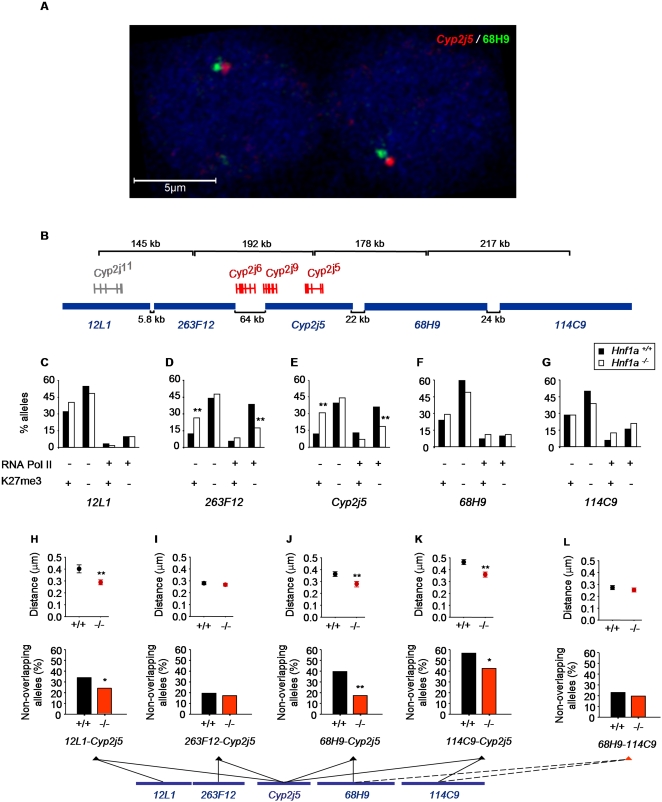
Spatial resolution of Hnf1α-dependent repositioning.(A) Two-color DNA FISH detection of adjacent loci Cyp2j5 (red) and 68H9 (green) in Hnf1a+/+ hepatocytes. (B) Schematic representation of the relative positions and distances (Kb) of BACs located centromeric (12L1 and 263F12) and telomeric (68H9 and 114C9) to Cyp2j5. Hnf1α-dependent genes in the region are drawn schematically in red. Note that no spliced transcript has been mapped to the region encompassed by BACs 68H9 and 114C9. (C–G) Classification of 12L1 (C), 263F12 (D), Cyp2j5 (E), 68H9 (F), and 114C9 (G) alleles into 4 categories according to the simultaneous enrichment (+) or non-enrichment (−) of RNA polymerase II (RNA Pol II) and H3-Lys27me3 (K27me3) in Hnf1a+/+ (black bars) and Hnf1a−/− (white bars) hepatocytes as described in Figure 3O–P. (H–L) Comparison of distances between the indicated BAC clone FISH signals in Hnf1a+/+ and Hnf1a−/− hepatocytes. For each comparison, the upper panels show the mean±SEM interlocus (signal center to center) distances in µm, with significance values calculated with the Mann-Whitney test. Lower panels show the percentage of non overlapping alleles, defined as those with signal center distances exceeding 0.4 µm, with significance values assessed with Fisher's exact test. *p<0.05, **p<0.01 relative to Hnf1a+/+ cells. More than 100 nuclei were analyzed in each case.